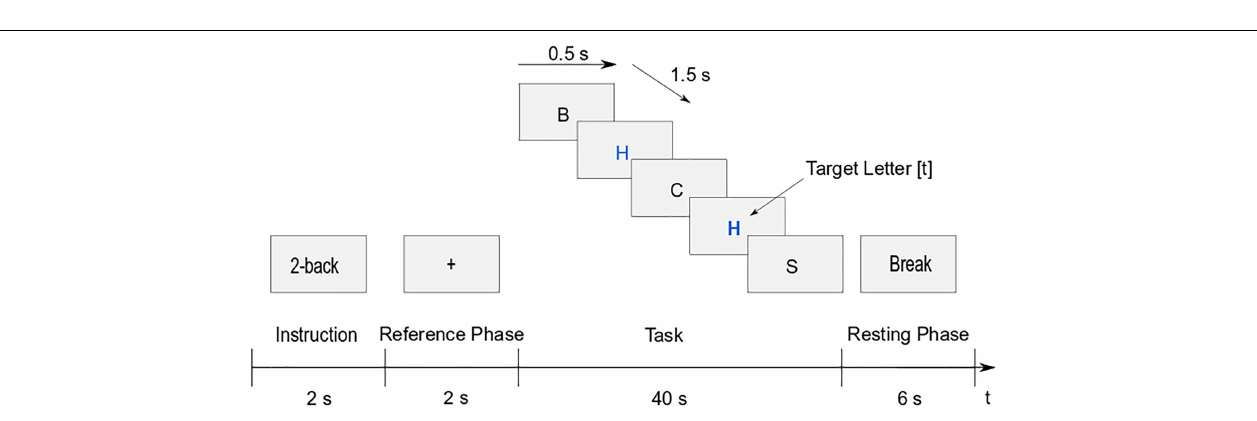
FIGURE 2 | Trial structure of the letter n -back task (example 2-back): Instruction (2 s), reference phase (2 s), task (40 s), and resting phase (6 s).